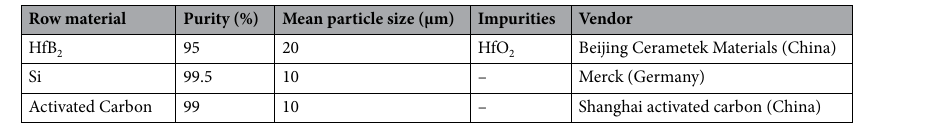
Table 2. Specification of the starting powders before